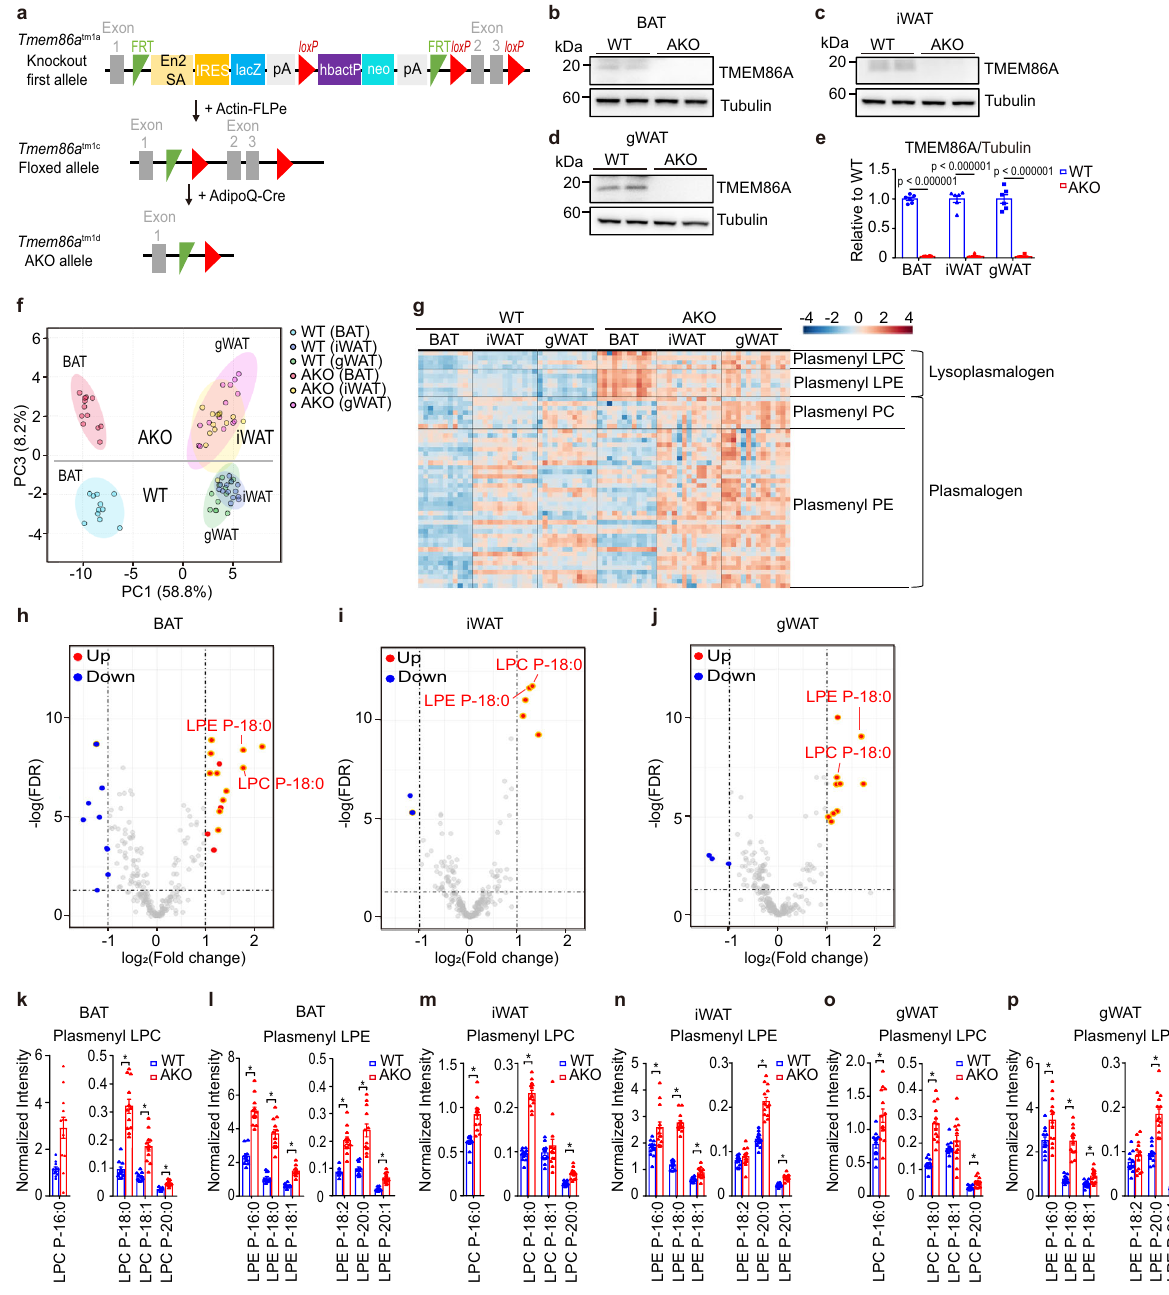
Fig. 3 Untargeted phospholipid pro fi ling of adipose tissue of adipocyte-speci fi c TMEM86A KO mice. a Schematic diagram showing generation of adipocyte-speci fi c TMEM86A knockout mice (TMEM86A AKO). b – e Immunoblot analysis of TMEM86A expression in adipose tissue of WT